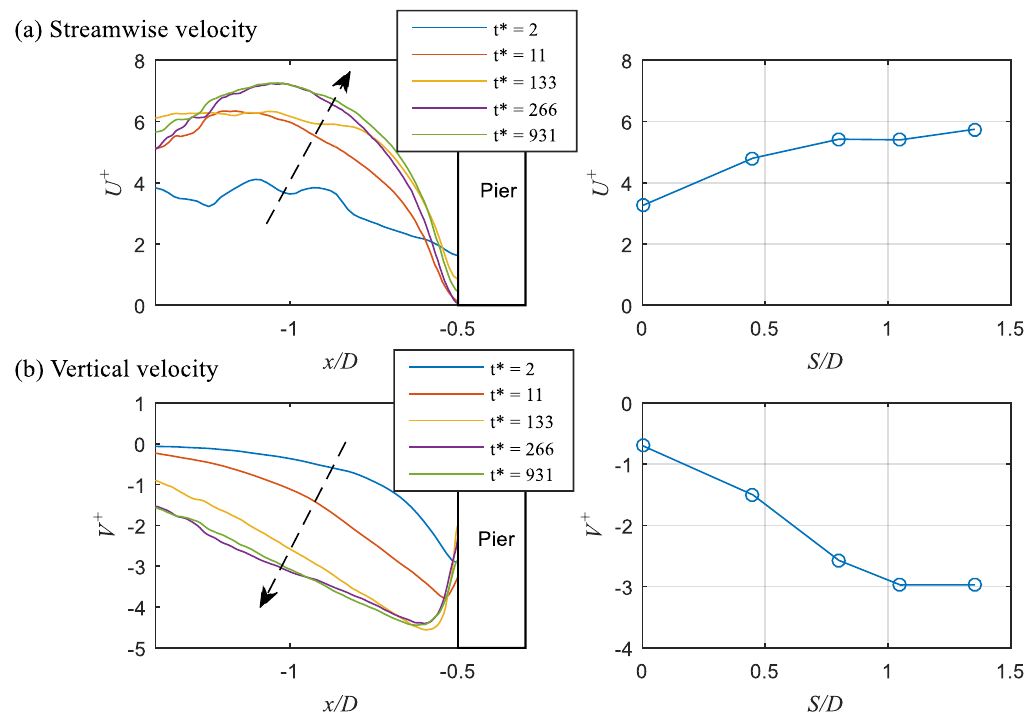
Figure 10. Velocity distributions along the center line at different time in the pier scouring process and the corresponding space-averaged value versus dimensionless pier scour depth. ( a ) streamwise velocity, ( b ) vertical velocity.